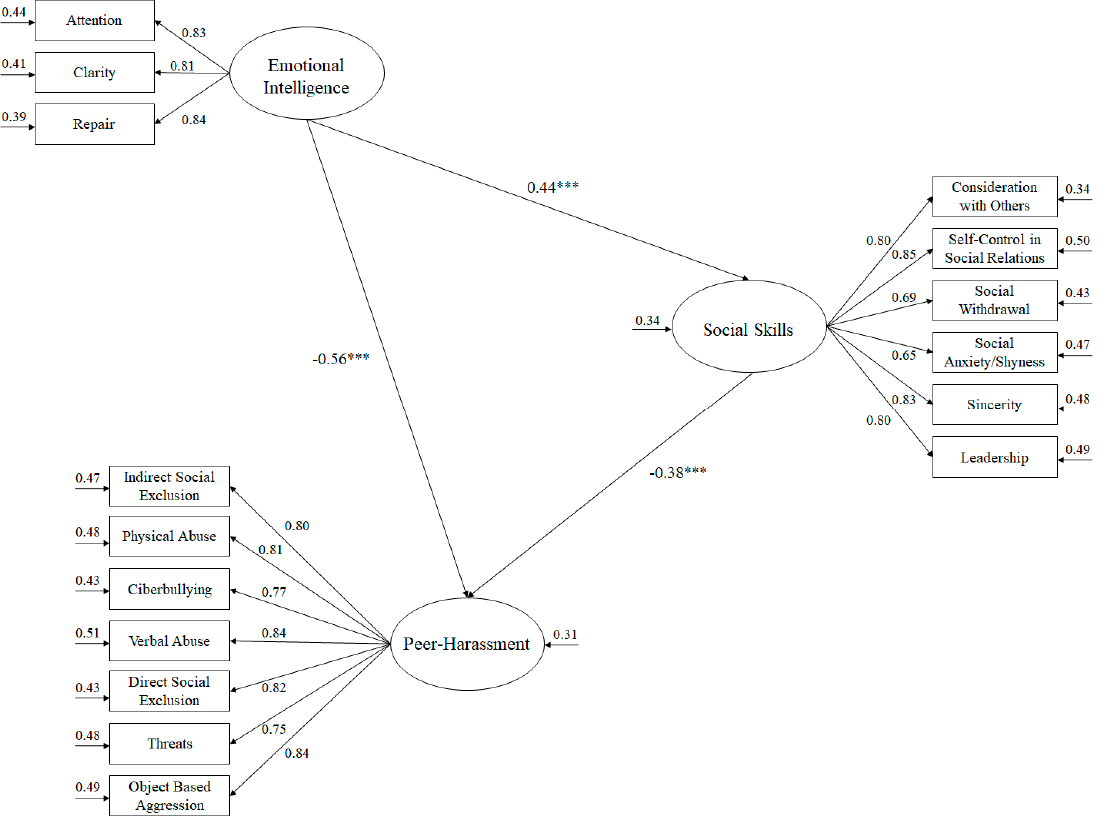
Figure 1. Structural equation model. The explained variances are shown on the small arrows. All parameters are standardized and statistically significant. Note: *** p < 0.001.